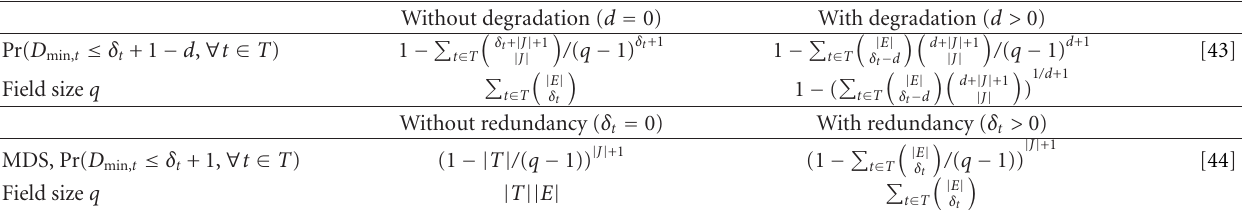
Table 3: Lower bounds for success probability of randomized coding and the required field size. Upper table shows the success probability, that is, the probability of having successful transmission with coding redundancy ( δ t = mincut( t ) − dim( C ), for all t ∈ T ) with and without degradation in the network up to d [43]. The lower table shows the success probability of generating a minimum distance separable (MDS) code with distance D min, t = mincut( t ) − dim( C ) + 1, with and without codebook redundancy [44]. J is the set of internal nodes. Without degradation ( d =